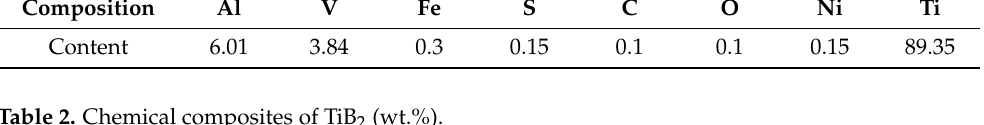
Table 1. Chemical composites of TC4 (wt.%).